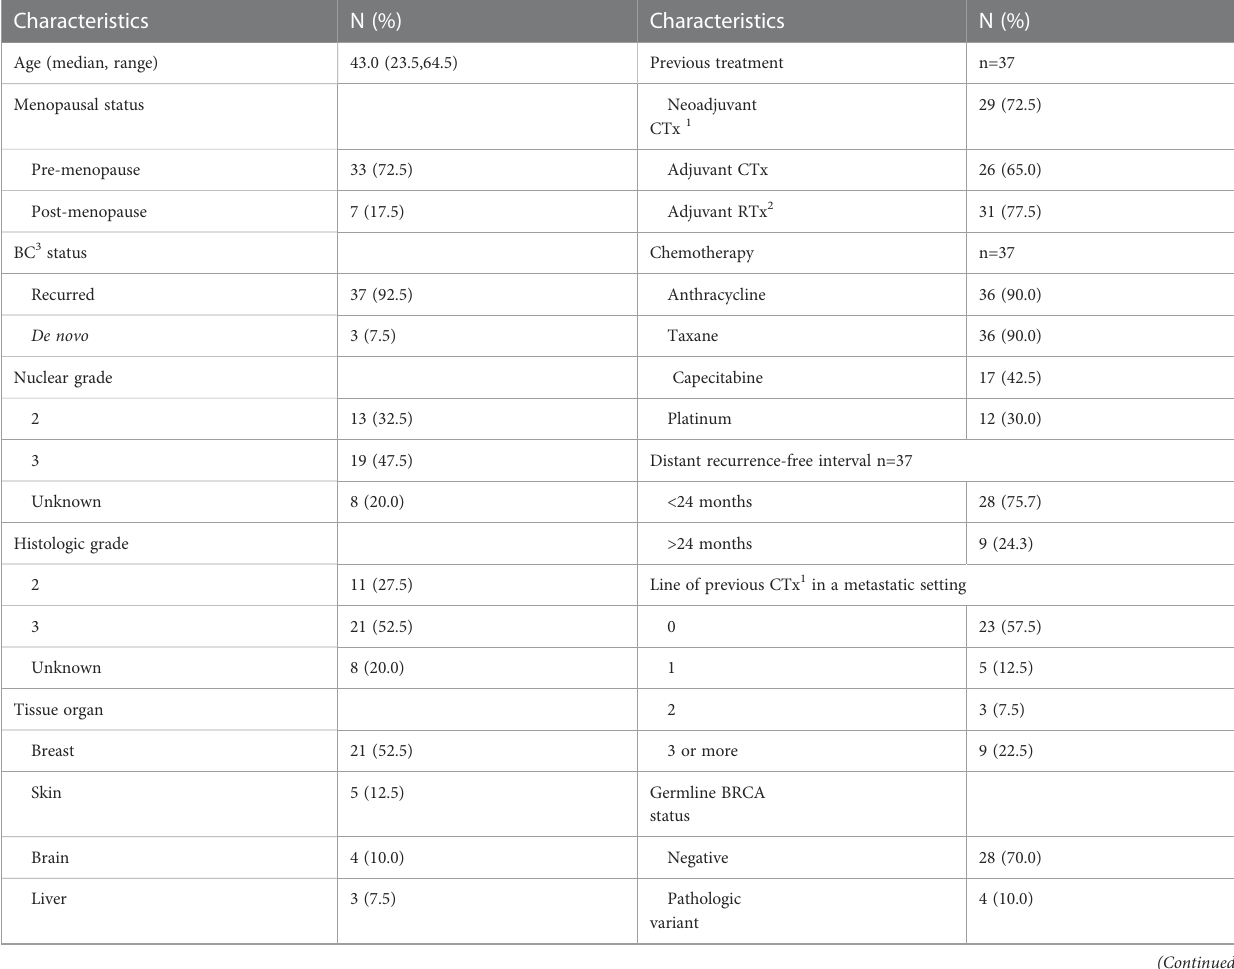
TABLE 1 Baseline clinical and pathologic characteristics